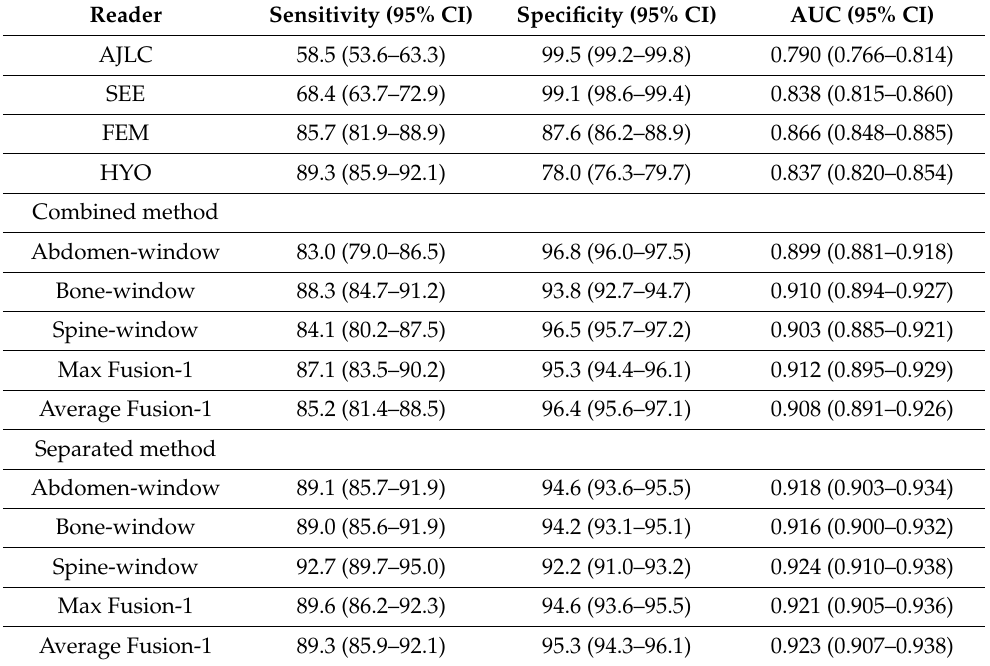
Table 5. Internal test set sensitivity, specificity, and AUCs for the DL model and radiologists using dichotomous Bilsky gradings (normal versus low/high) on